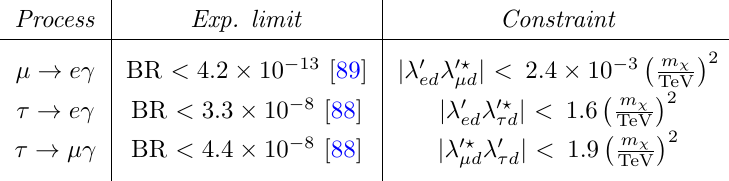
‘ (cid:12) (cid:13) processes mediated by LQ. !